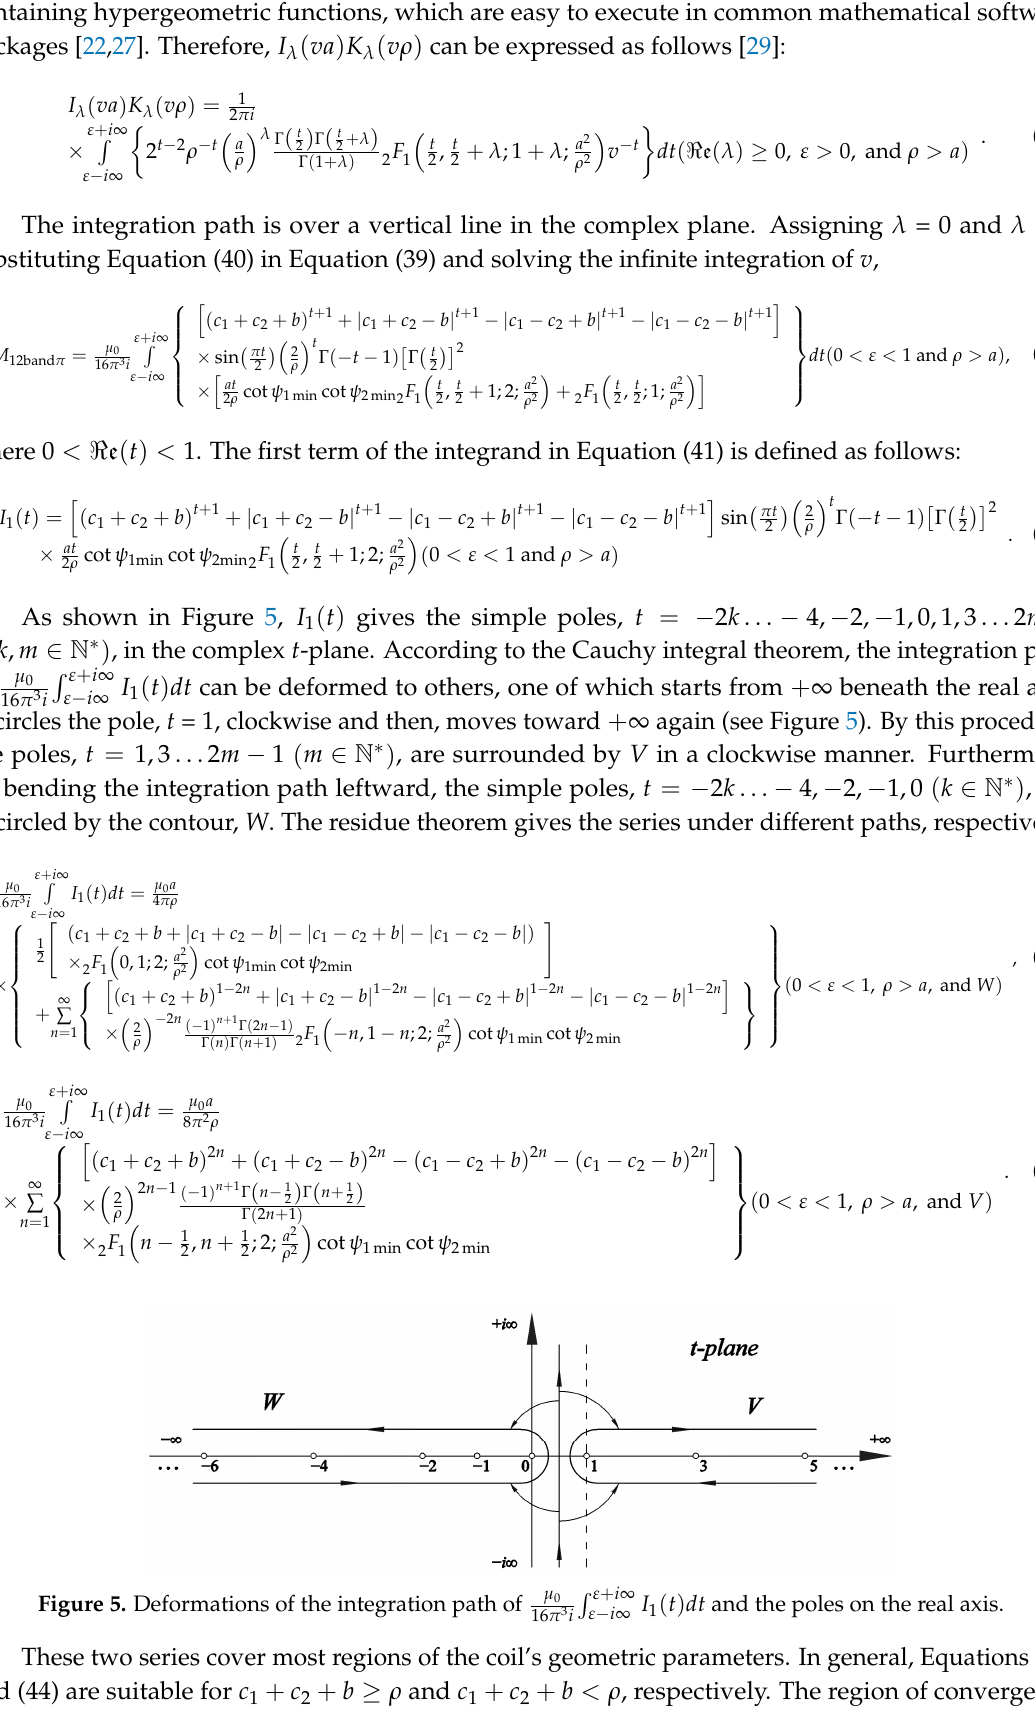
Figure 5. Deformations of the integration path of µ 0